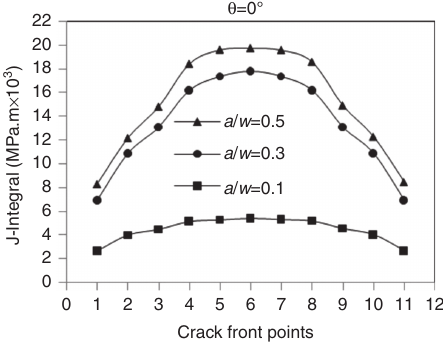
Figure 19 Effect of crack length on J-integral.